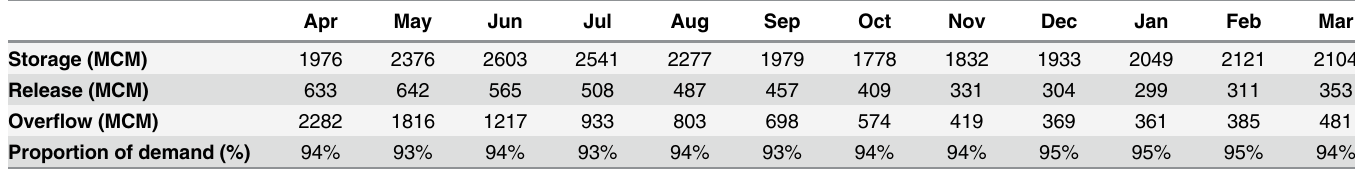
Table 3. The average reservoir storage, release rate, overflow rate and proportion of water demand of Karun 1 (while: λ 1 = 0 & λ 2 = 1).